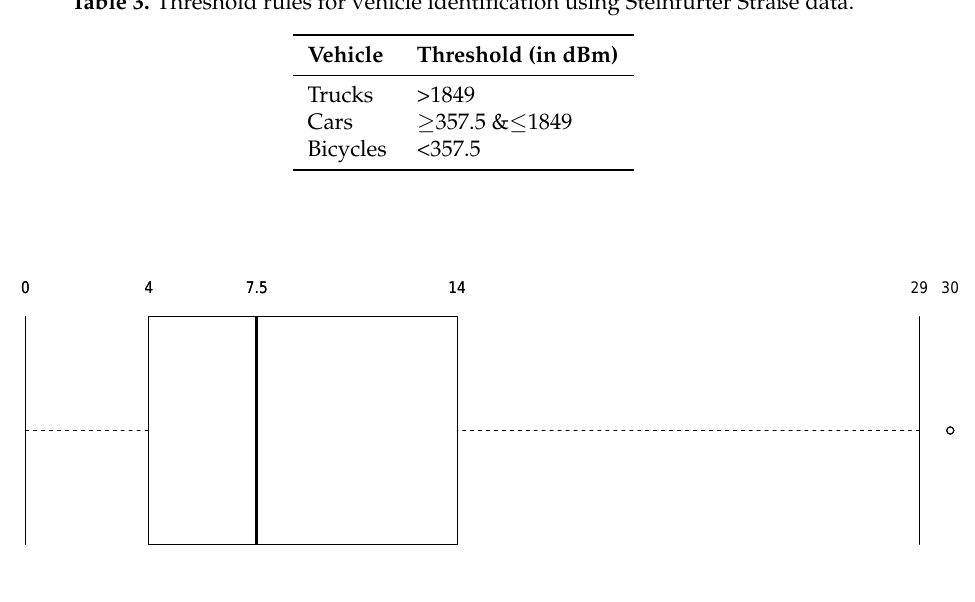
Table 3. Threshold rules for vehicle identification using Steinfurter Straße data.